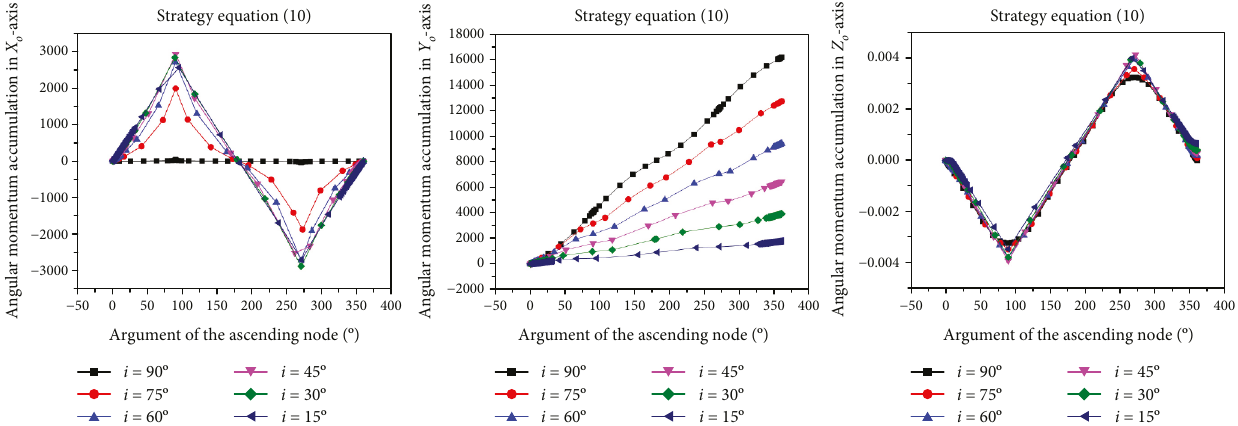
Figure 12: Angular momentum accumulation in the circular orbit (1950km) with di ff erent inclinations under equation (10) (example 7).